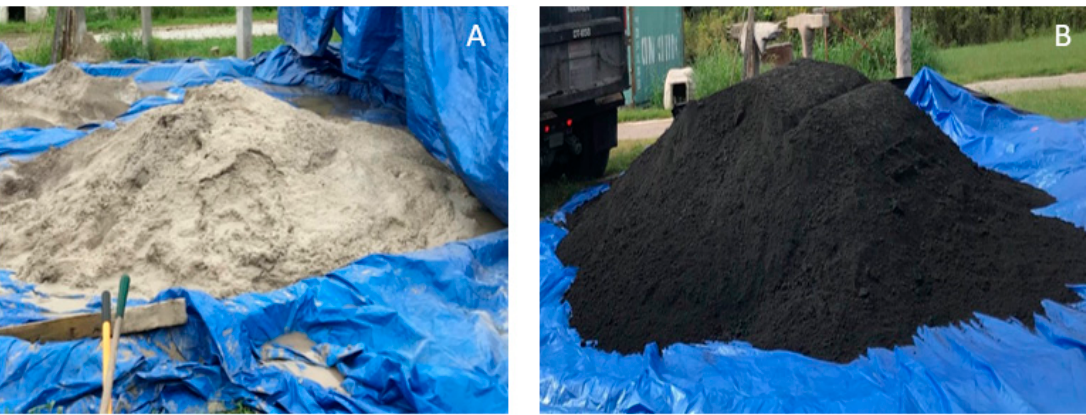
Figure 1. ( A ) Plant D fly ash as delivered in June 2018. ( B ) Plant I fly ash as delivered in August 2018.